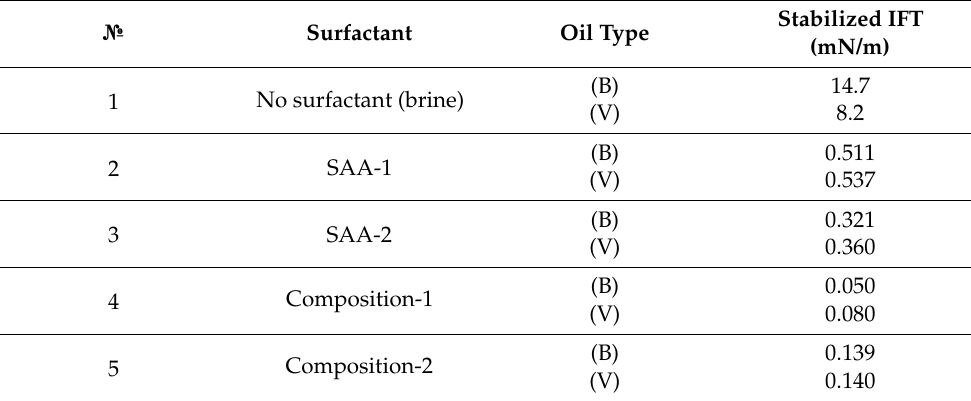
Table 5. Results of IFT